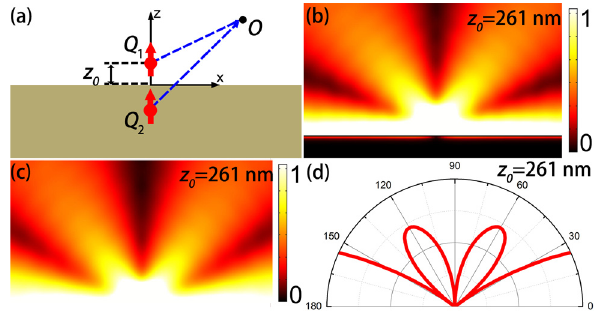
Figure 5: (a) Two-dimensional simplified image dipole model. A z -oriented primary dipole ( Q 1 ) is placed above a gold substrate. The image dipole ( Q 2 ) with the same orientation and magnitude is at the mirror point of the dipole. The separation between the dipole and the gold substrate is z 0 . (b) Intensity ( | E | 2 ) distribution of a z -oriented pri- mary dipole located above a gold substrate ( z 0 = 261 nm). (c) Intensity ( | E | 2 ) distribution of the interference between the primary dipole and the image dipole ( z 0 = 261 nm). (d) Polar plots of the interference pattern of the primary dipole and the image dipole in the polar coor- dinate system ( z 0 = 261